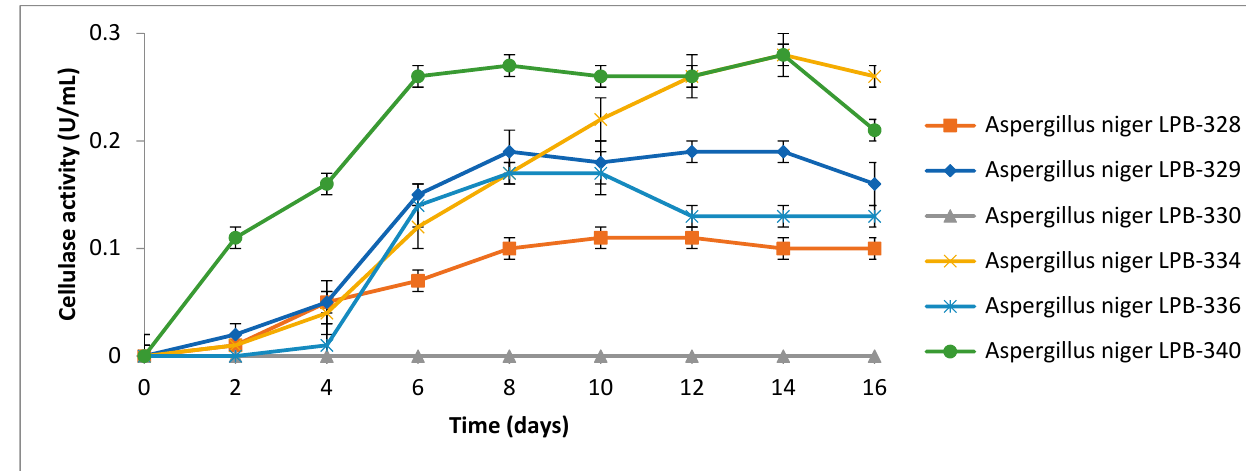
Figure 1. Time course of cellulase activity production in liquid culture by Lentinus edodes strains. The error bars represent standard deviations . The averages of results of three independent experiments, each one performed with three biological replicates, are reported.